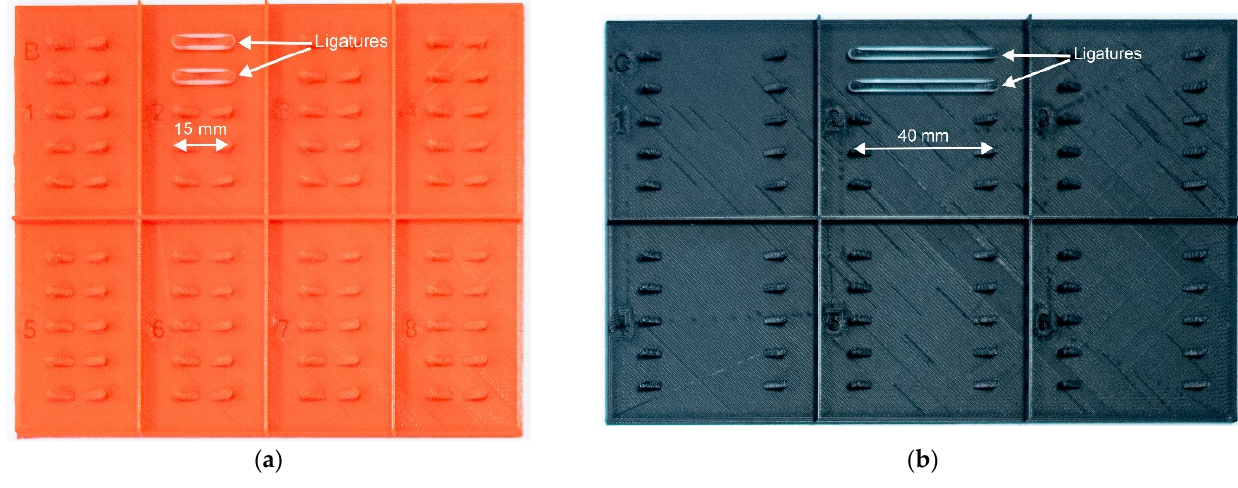
Figure 4. ( a ) The 15 mm ligature holder with two sample ligatures. ( b ) The 40 mm ligature holder with two sample ligatures.